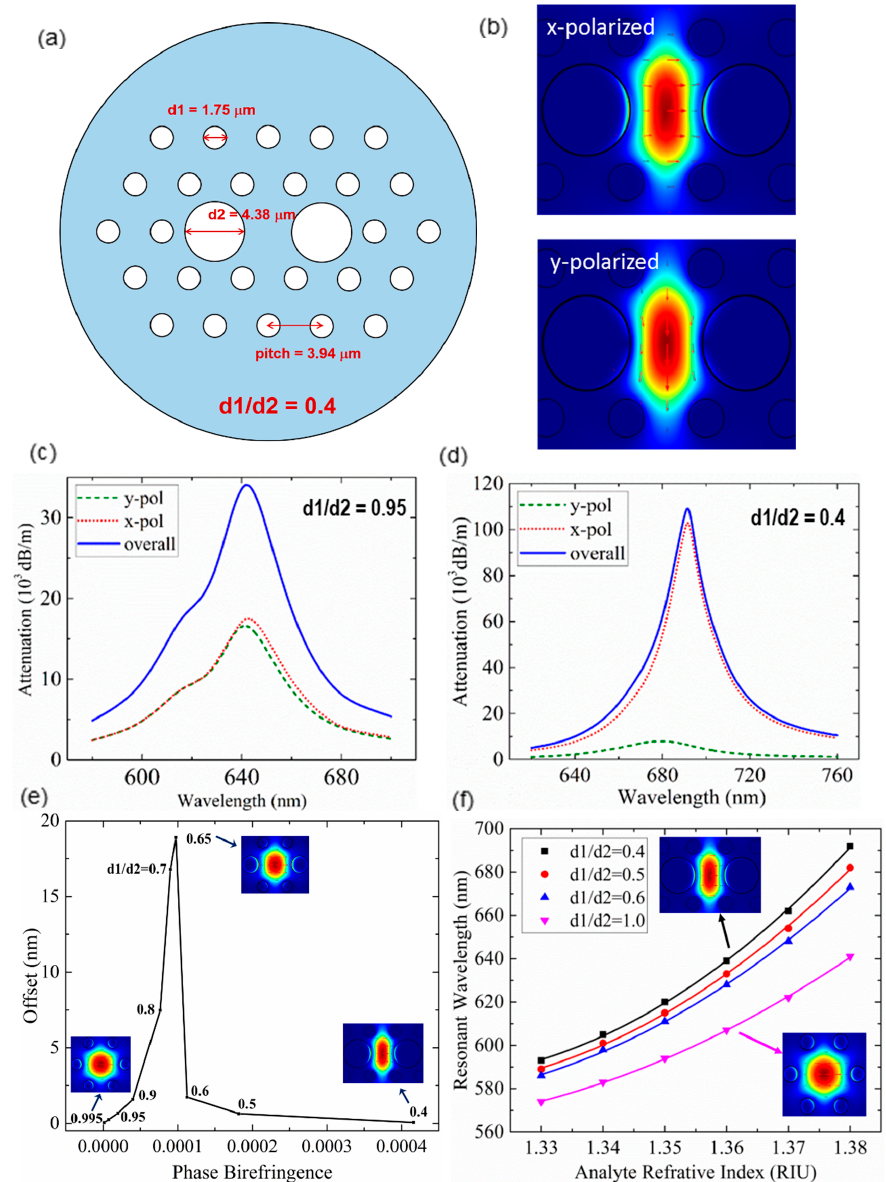
Figure 3. ( a ) The configuration of proposed highly birefringent microstructured optical fiber (MOF). ( b ) x-polarized and y-polarized core mode pattern of the SPR sensor (d1 / d2 = 0.4) (Figure adapted with permission from reference [31]). ( c ) Attenuation spectra of highly birefringent MOF when d1 / d2 = 0.95 and ( d ) d1/d2 = 0.4. ( e ) The variation of wavelength offset along with phase birefringence. (Inset) The x-polarized core mode pattern. ( f ) The SPR sensitivities when d1/d2 = 1.0, 0.6, 0.5 and 0.4 respectively. (Inset) The x-polarized core mode (Figure adapted with permission from reference [32]).